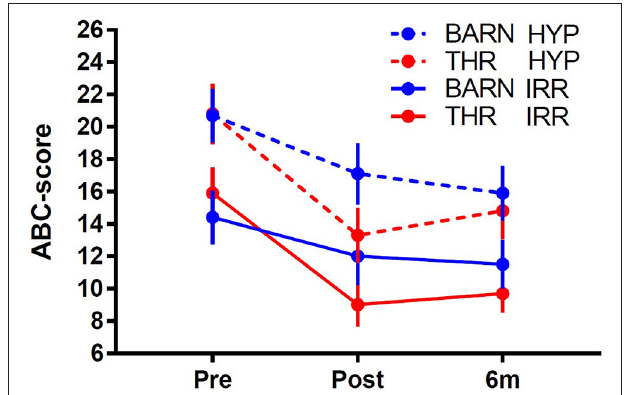
FIGURE 1 | Profile of irritability (IRR) and hyperactivity (HYP) over three assessment periods. Note, the typical clinical threshold for the ABC-C irritability subscale is > 14–16 in psychopharmacology clinical trials for the ASD population [e.g., (27, 28)].